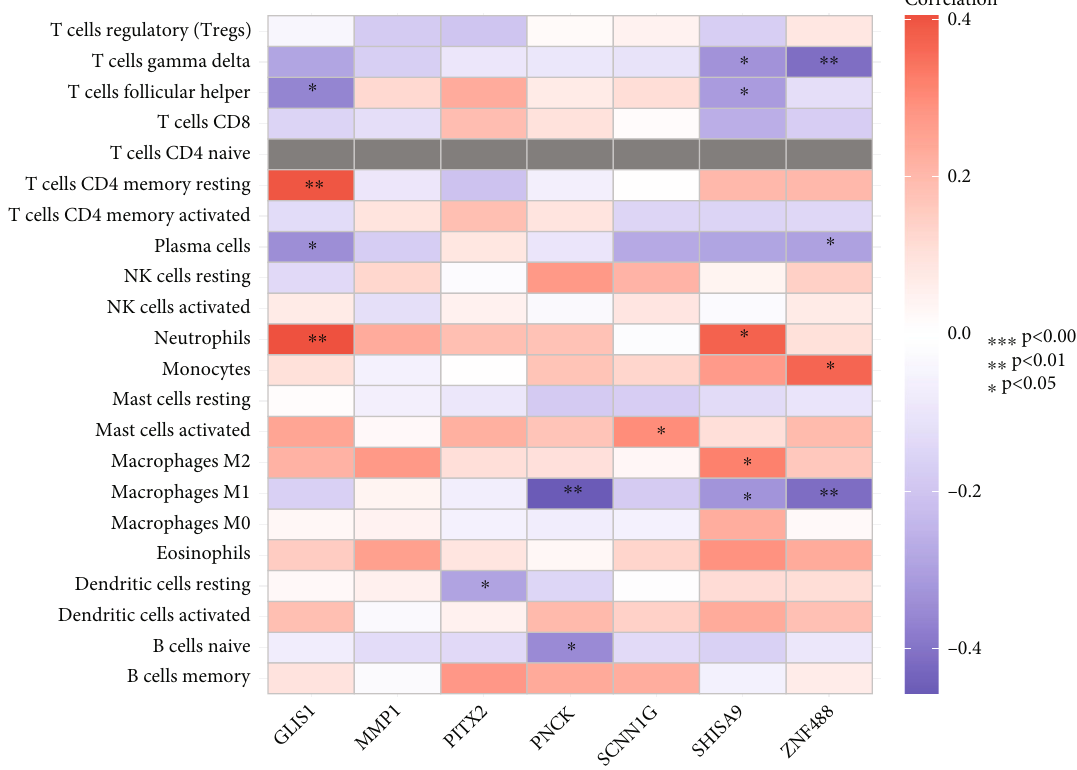
Figure 5: Seven genes, respectively, in relation to the level of immune cell in fi ltration. ∗ P < 0 : 05 , ∗∗ P < 0 : 01 , and ∗∗∗ P < 0 : 001